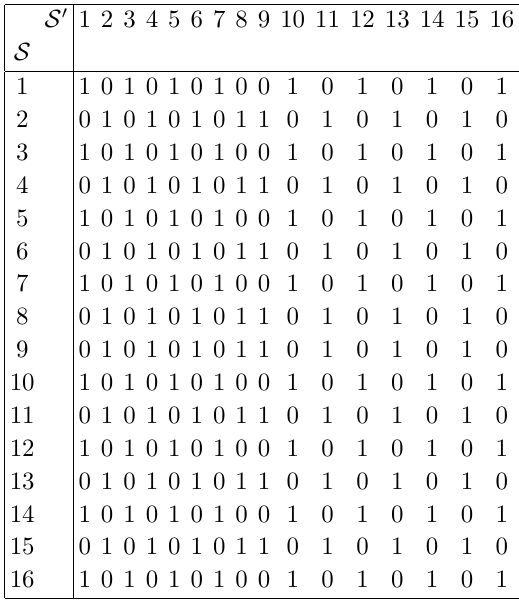
Table 35 . Gadget values for P